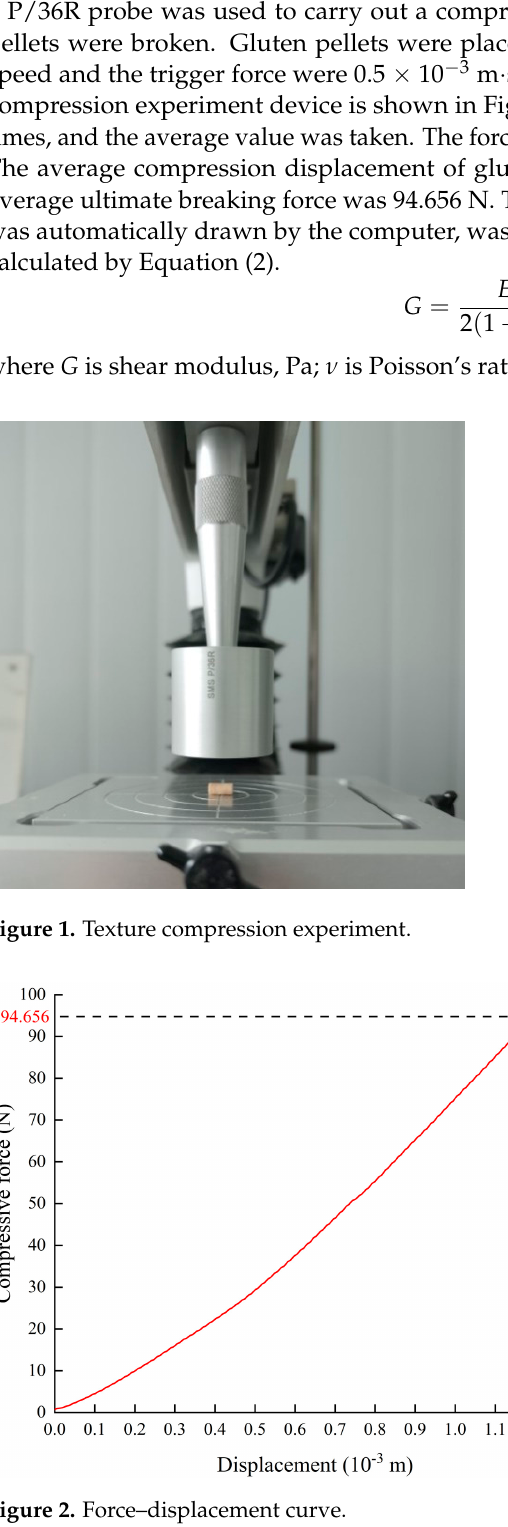
Figure 2. Force–displacement curve.